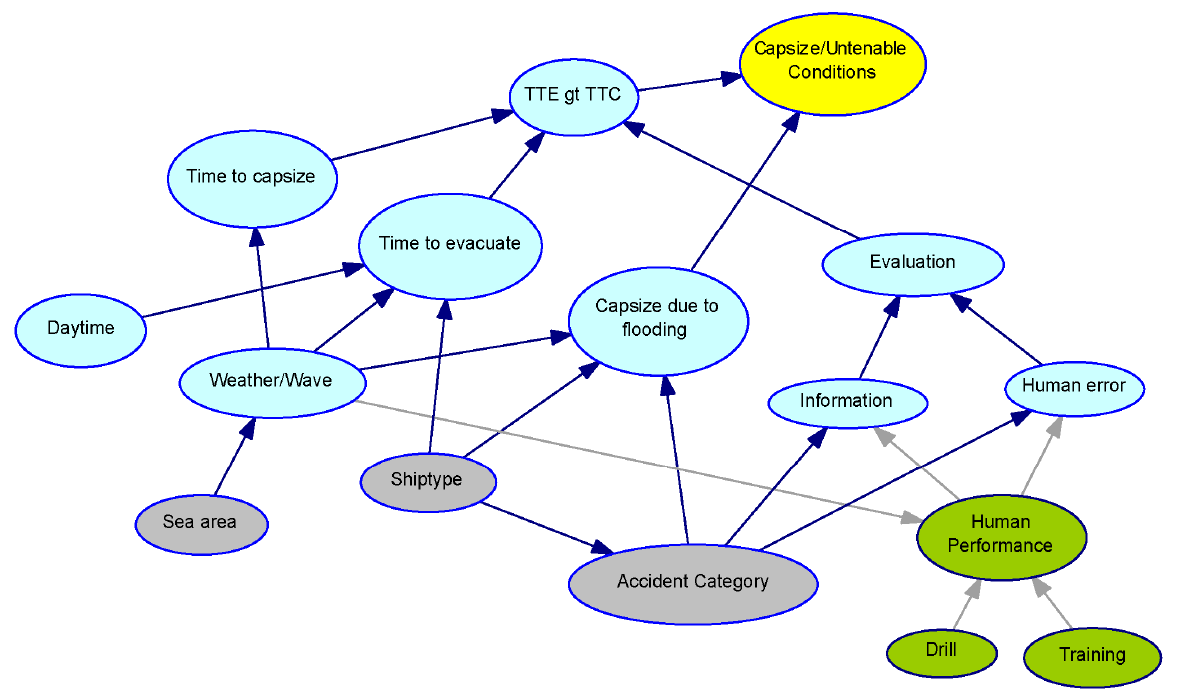
Figure A1. A Bayesian network for capsize/untenable conditions in flooding accidents (01).